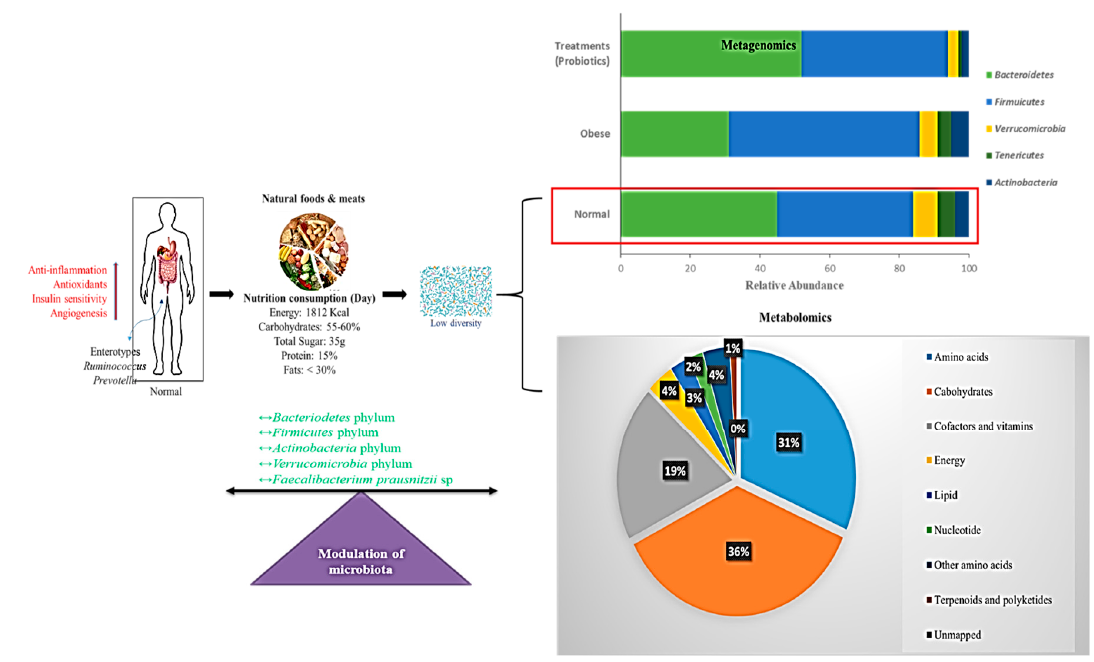
Figure 3. Schematic representation of a normal diet in the modulation of gut microbiota. Interactions between normal diet, nutrition, energy intake, and modulation of microbiota are shown. Bar chart represents the metagenomics results on operational taxonomic units (OTUs) grouped in phyla. Pie chart shows the percentage of metabolic effects influencing normal diet. Red arrows indicate increased activity